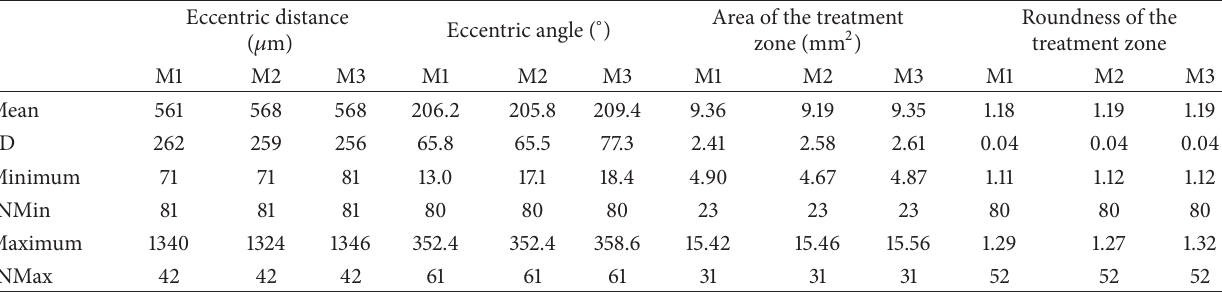
Table 1: Measurement results ( 𝑛 = 81